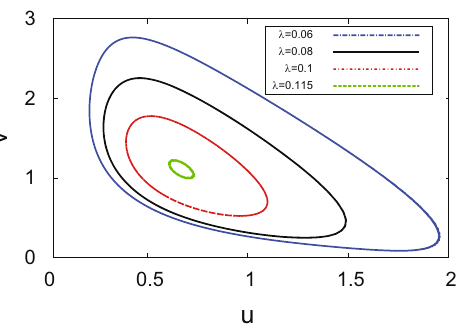
Figure 10: Phase plane u v − illustrating the limit cycle curves for di ff erent values of bifurcation parameter λ 0.06, 0.08, 0.1 = , and 0.115. Other parameters are as in Figure